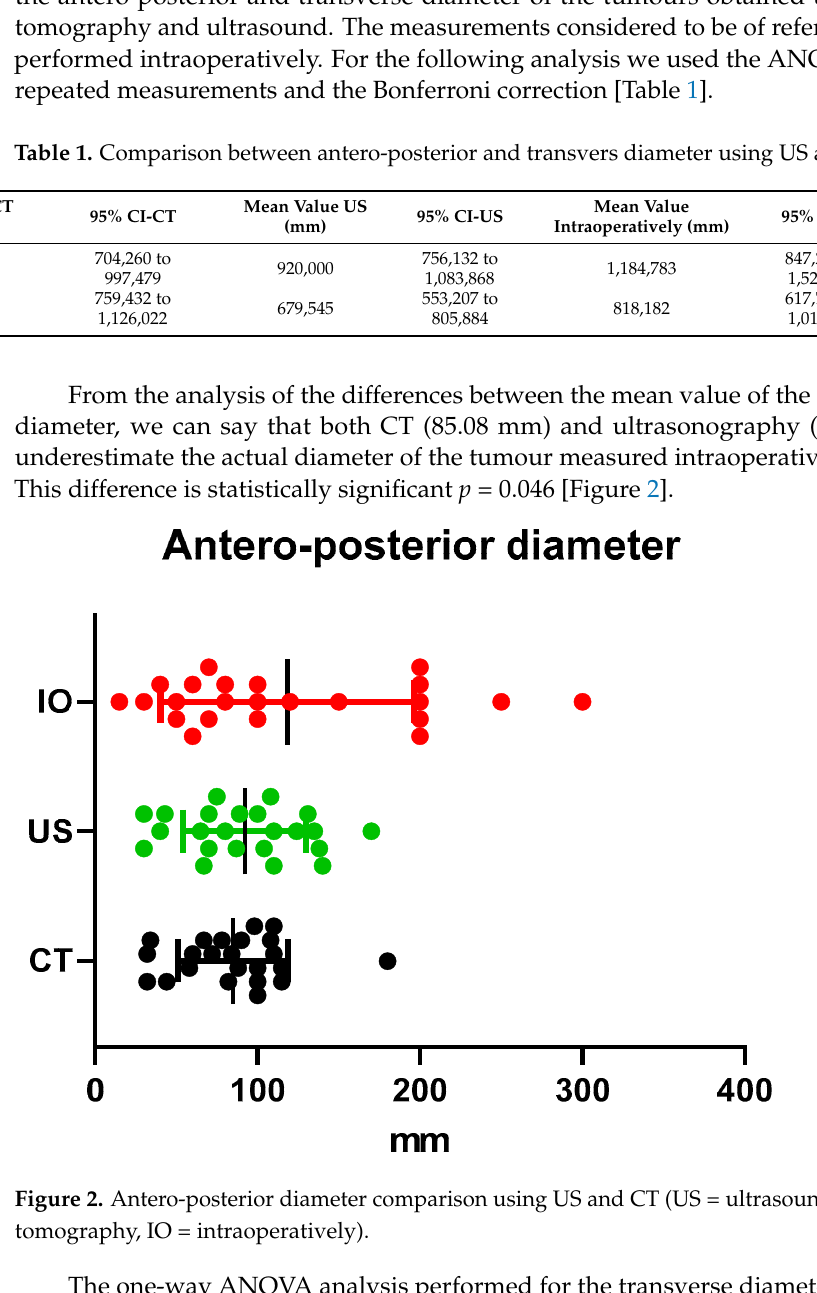
Table 1. Comparison between antero-posterior and transvers diameter using US and CT.